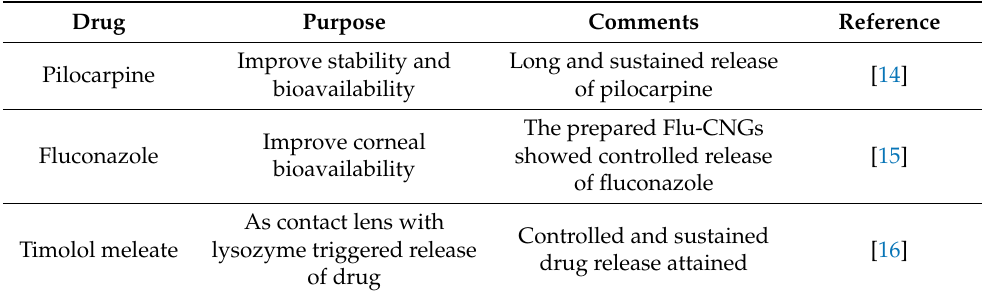
Table 1. Delivery of nanogel incorporated